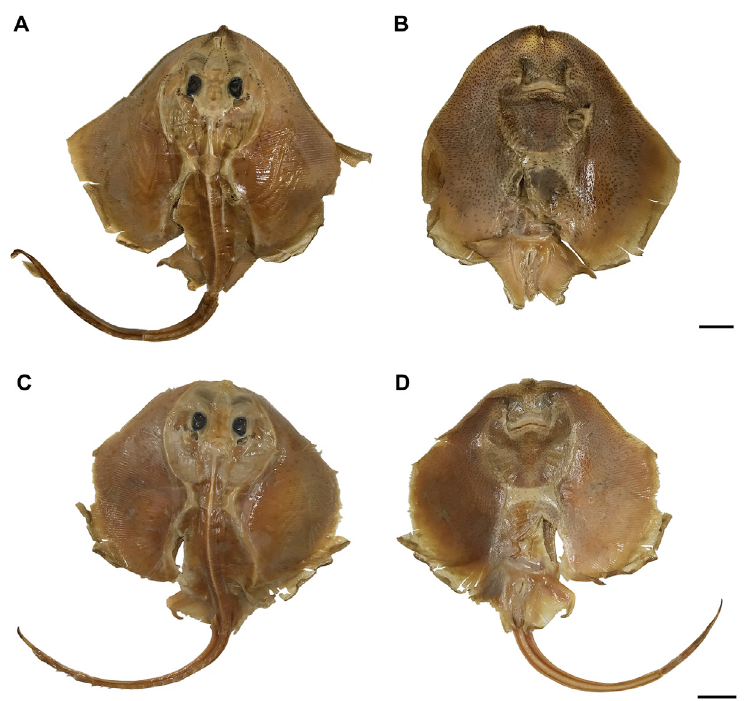
FIGURE 1 | Types of Atlantoraja castelnaui . A , B. MNRJ 608, female, 318.2 mm TL, lectotype; C , D. MNRJ 19314, male, 226.3 mm TL, paralectotype. Scale bars = 10